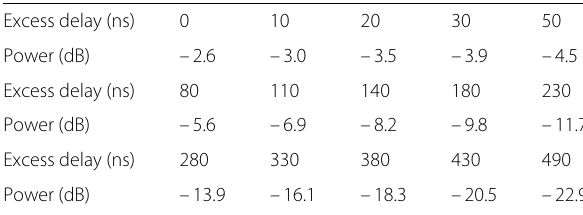
Table 2 802.11 indoor channel